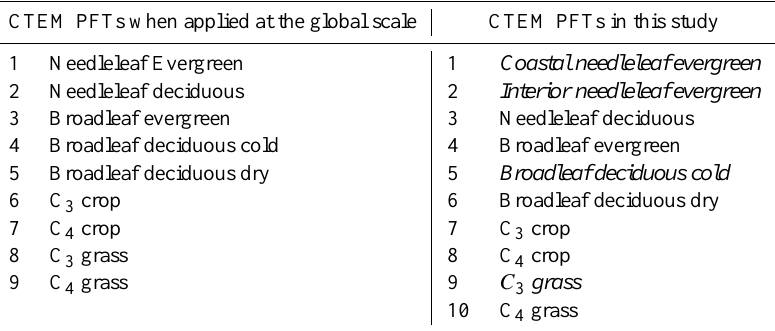
Table 1. Plant functional types (PFTs) for which terrestrial ecosystem processes are modelled by CTEM in its default configuration at the global scale and for this study. CTEM PFTs that are present in the province of BC (see Fig. 1) are shown in italic.